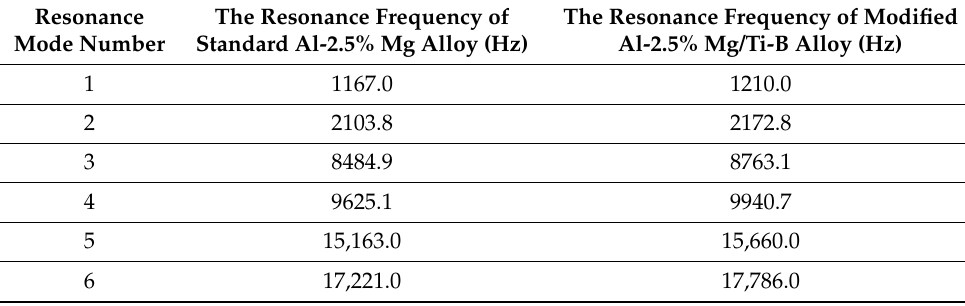
Figure 12. Graphical representation of the simulation results of the resonant frequencies at the first six modes.